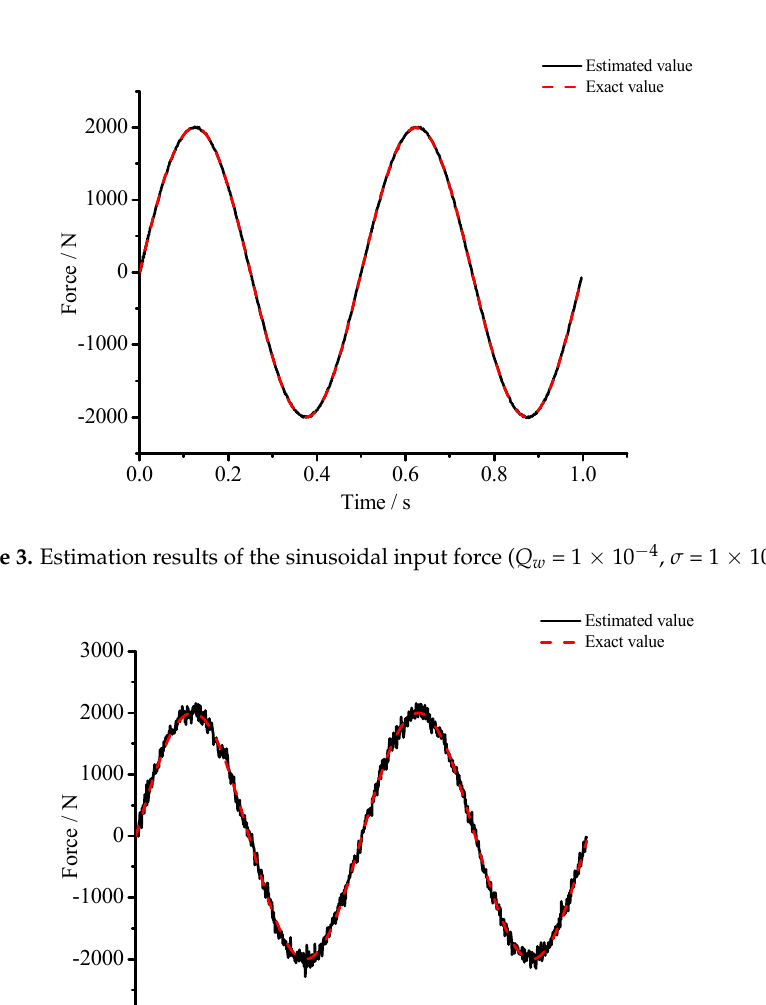
Materials 2017 , 10 , 1162